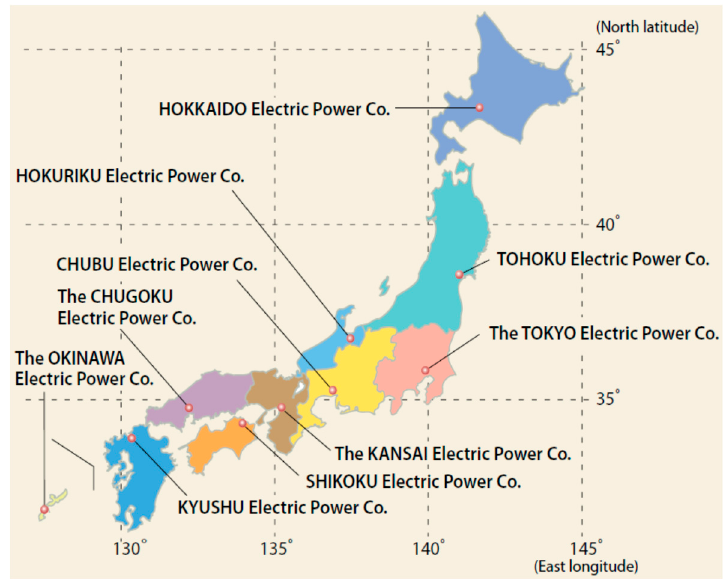
Figure 3. Ten electric power companies by service area. (Source: Electricity Review Japan, The Federation of Electric Power Companies of Japan 2012.)